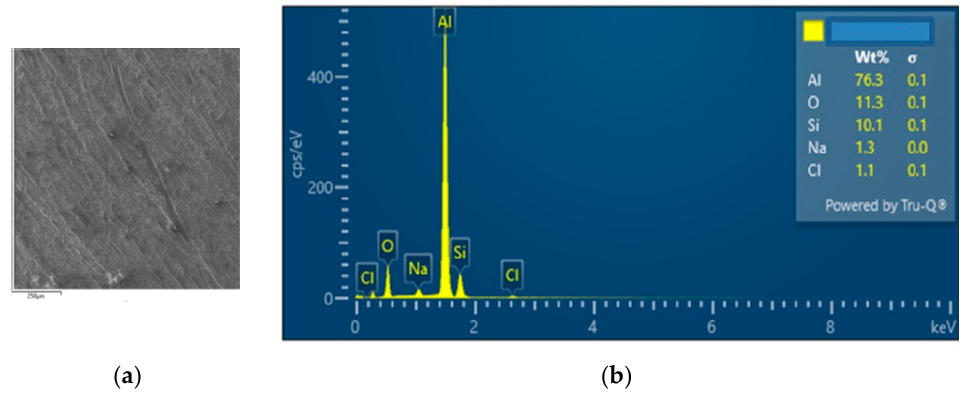
Figure 12. EDX analysis and its evaluation with respect to the local chemical composition: ( a ) chemical composition of the AlSi12 alloy used; ( b ) sample SAM3.